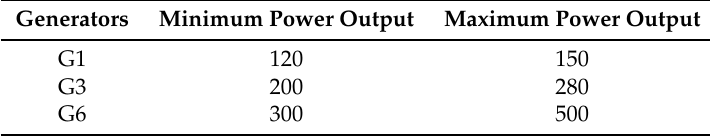
Table 4. Limited Operation Range of Generators (MW).